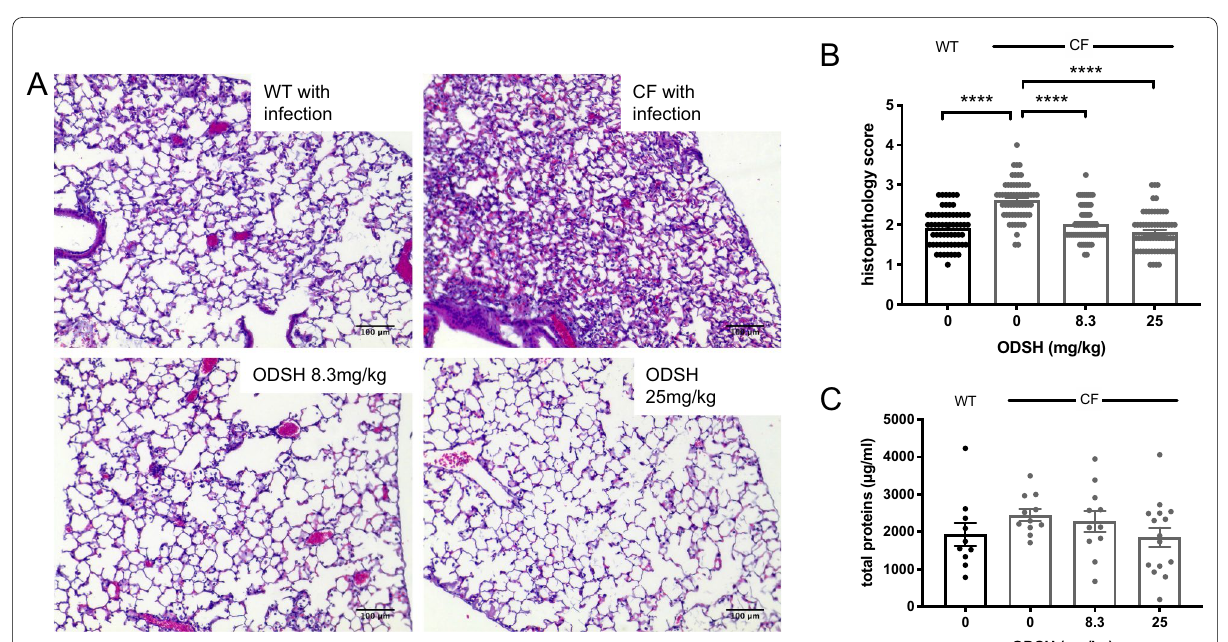
Fig. 1 ODSH attenuates lung injury in CF with PA infection. C57BL/6 mice (WT) and CFTR − / − mice (CF) were intratracheally inoculated with Pseudomonas aeruginosa (PA) at T 0 and were randomized to receive via i.p. administration of saline or ODSH at 8.3 or 25 mg/kg at T 0 = = and T 12 h. 18 h post PA inoculation (T 18 h), mouse lungs were perfused with 4% formaldehyde and harvested from the mice, followed = = by paraffinization, tissue sectioning and H&E staining. A Histological analysis was performed and the B level of lung injury was scored. C Bronchoalveolar lavage fluid (BAL) was collected 18 h after infection and was analyzed for total protein content by bicinchoninic acid assay (BCA), which serves as a marker of lung injury. Data represent mean SEM of three independent experiments (n 10–14 mice) for each group. One-way ± = ANOVA was used for multiple group comparison to determine statistical significance between control CF group and other groups. ****, P < 0.0001 compared to the control CF mice administered with